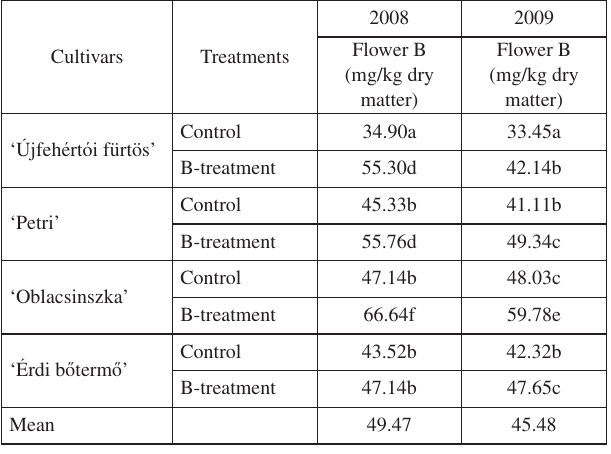
In each column, means followed by the same letter are not significantly different Table 4: Results of leaf analysis (Újfehértó, Hungary, 2008–2009)